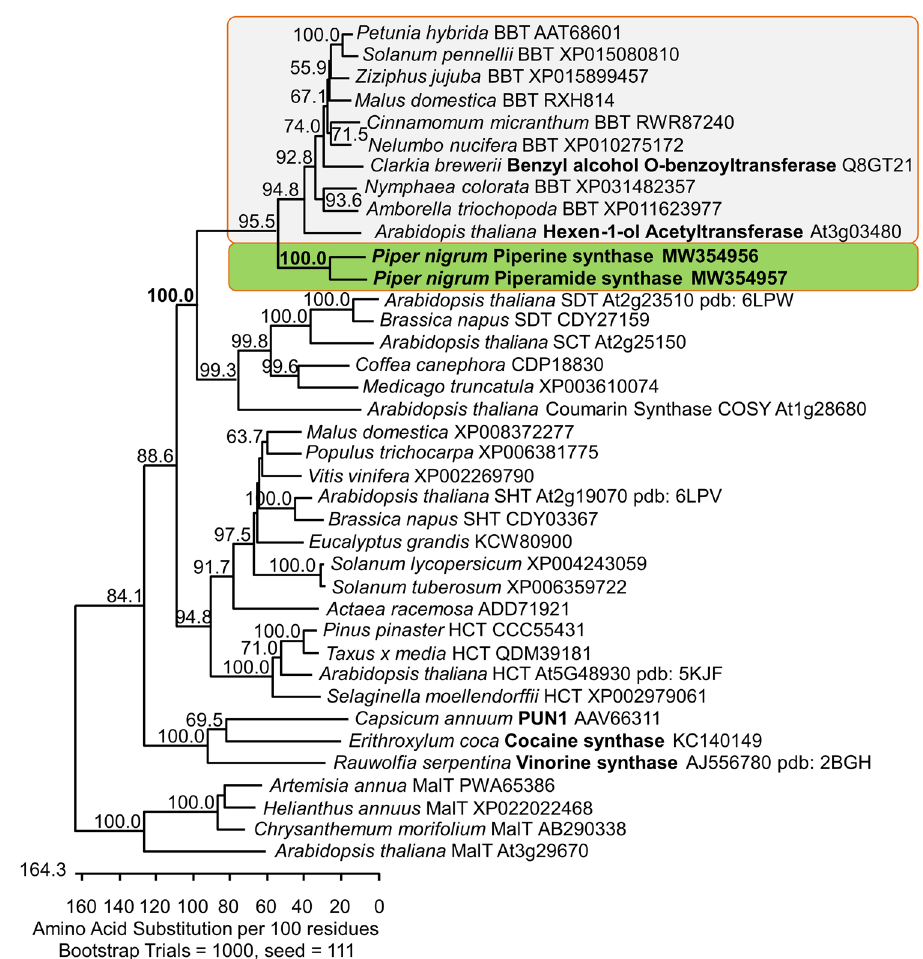
Fig. 6 Bootstrapped, unrooted cladogram of piperine and piperamide synthases among BAHD-like acyltransferases. Piperine synthase and closely related piperamide synthase from black pepper are marked in bold green. Functionally characterized benzoyl-CoA benzoate transferases (BBTs) and ( Z )- hexen-1-ol acetyltransferase from Arabidopsis (in a gray box) 28,32 represent clade V of BAHD-like acyltransferases but are distinct from piperine and piperamide synthases. Clusters harboring capsaicin synthase 19 , vinorine synthase 33 , malonoyltransferases 34 , cocaine synthase 35 , hydroxycinnamoyltransferases (HCTs), and spermidine hydroxycinnamoyl transferases (SHTs, SDTs and SCT) share <25% amino acid sequence identity to piperine and piperamide synthase, respectively. Either NCBI accession numbers, Arabidopsis gene entries (www.tair.org), and/or the pdb-accession number of crystallized and functionally characterized synthases are shown and are also listed in Supplementary Data